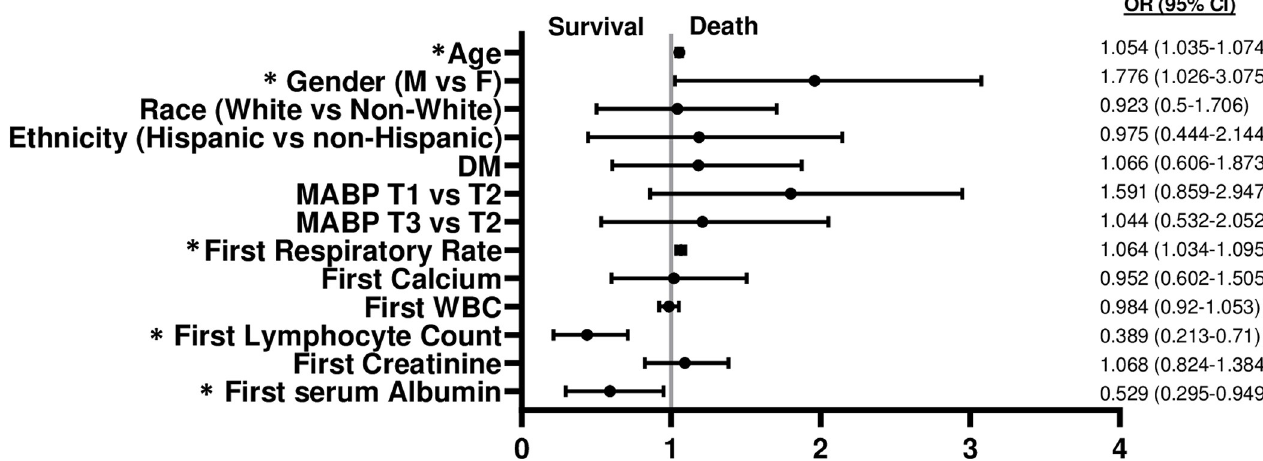
Fig 3. The OR of variables that predict mortality in subjects without a history of HTN and hospitalized with COVID-19